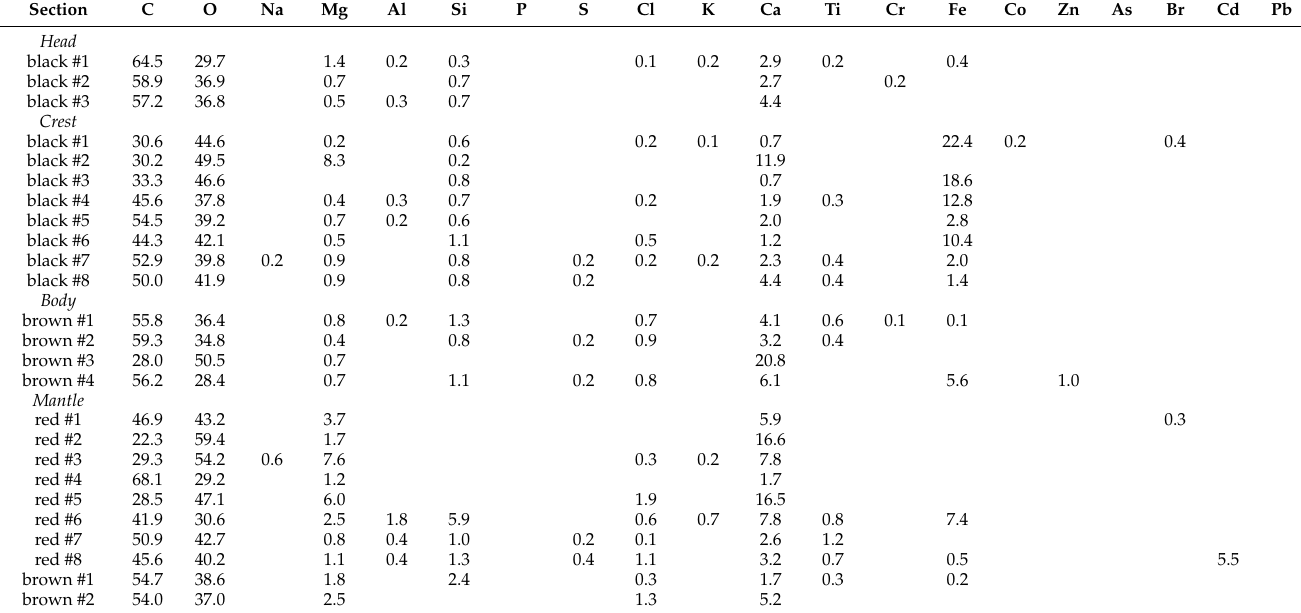
Table 1. Levels (as %) of heavy metals determined by X-ray EDS in different parts of a sample, specifically a gladiator.